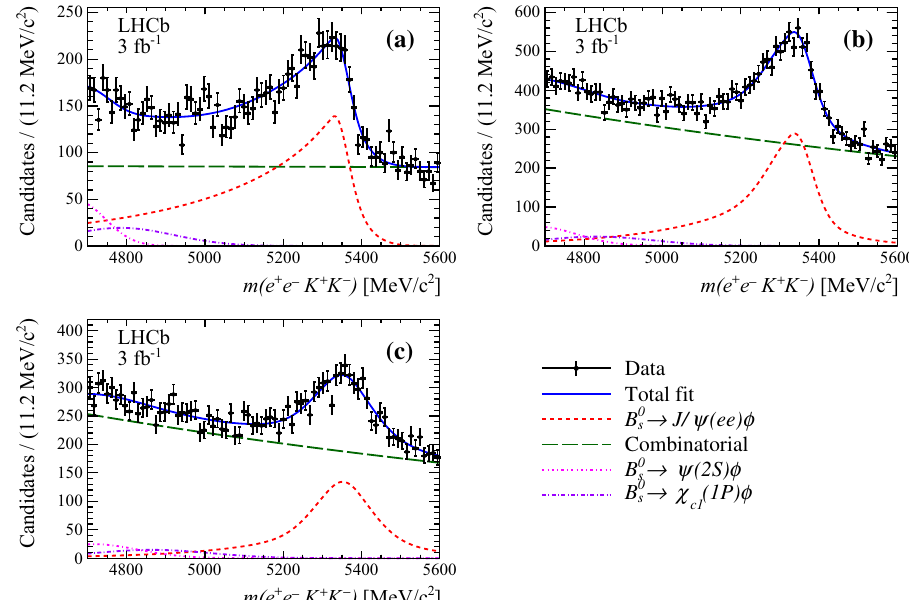
Fig. 2 Distribution of m ( e + e − K + K − ) for selected B 0 s → J /ψφ candidates divided into three categories: a zero, b one and c both electrons with bremsstrahlung correction. The blue solid line shows the total fit which is composed of (red short-dashed line) the signal and the background contributions. The combinatorial background is indicated by the green long-dashed line while the partially reconstructed background from the B 0 s → ψ( 2 S )φ and B 0 s → χ c 1 ( 1 P )φ decays are indicated by pink and purple dash-dotted lines,